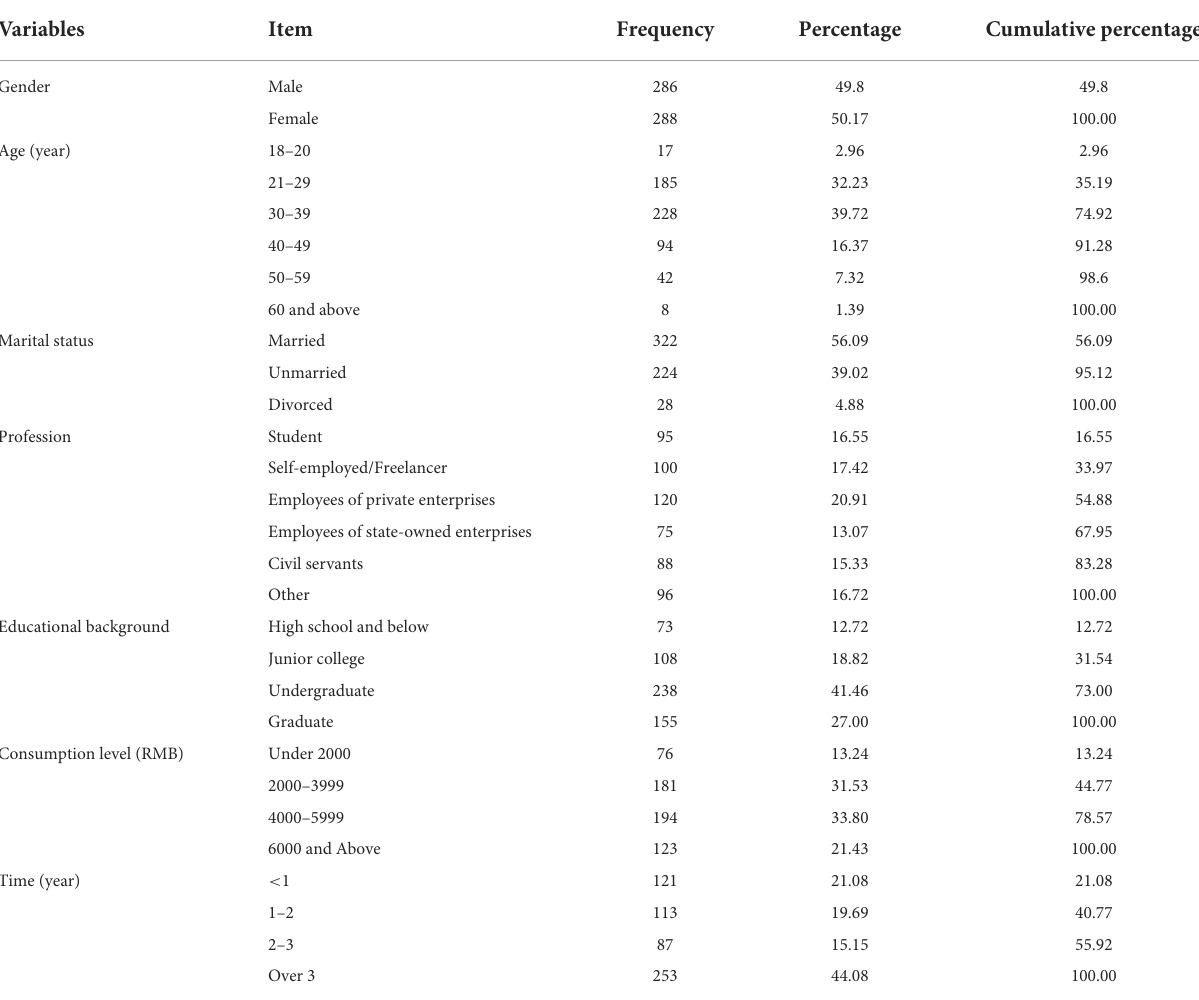
TABLE 5 Analysis of basic data of